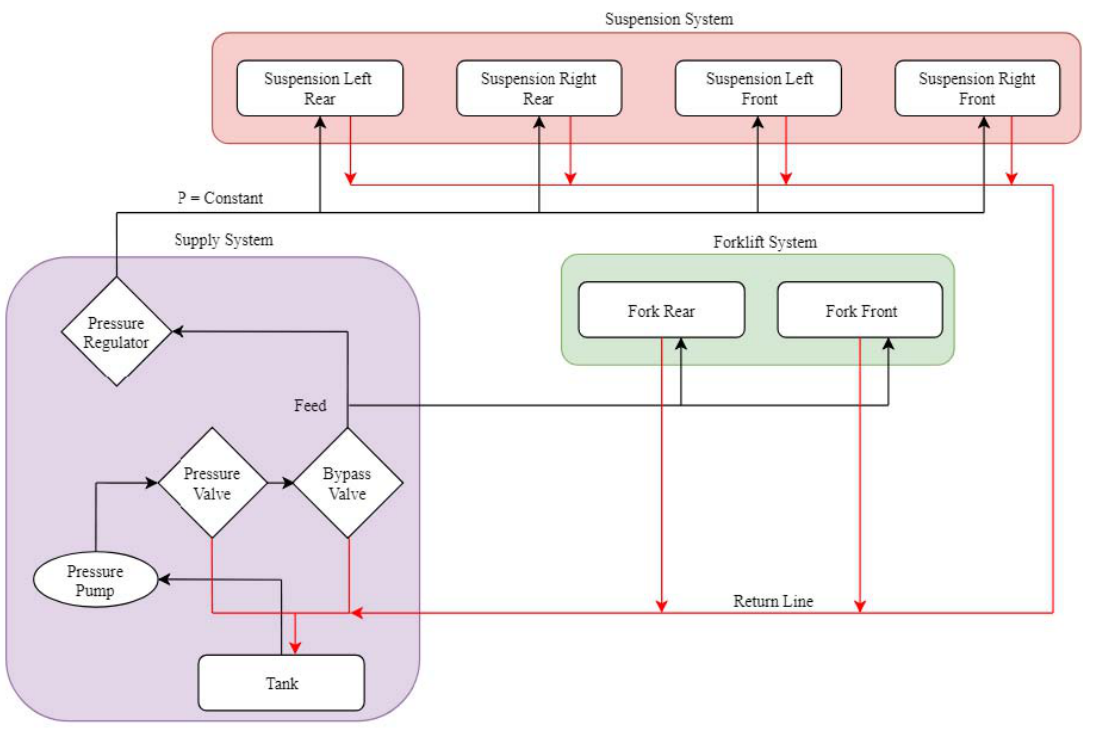
Figure 1. Overview of the hydraulic systems installed in FURBOT.